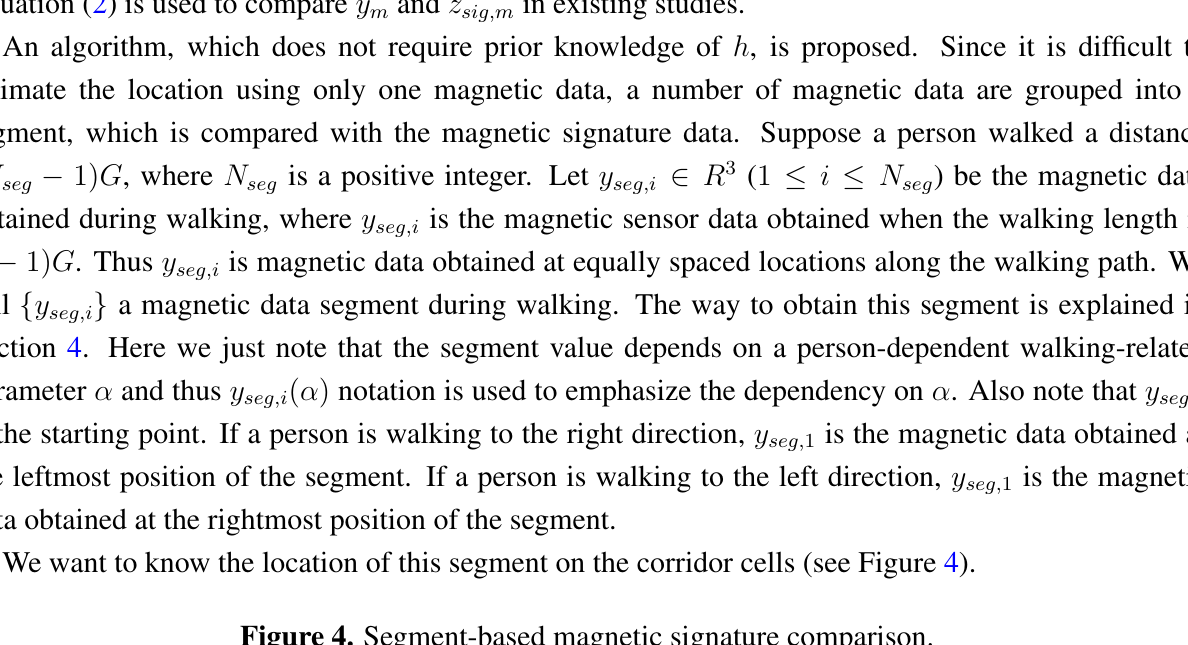
Figure 4. Segment-based magnetic signature